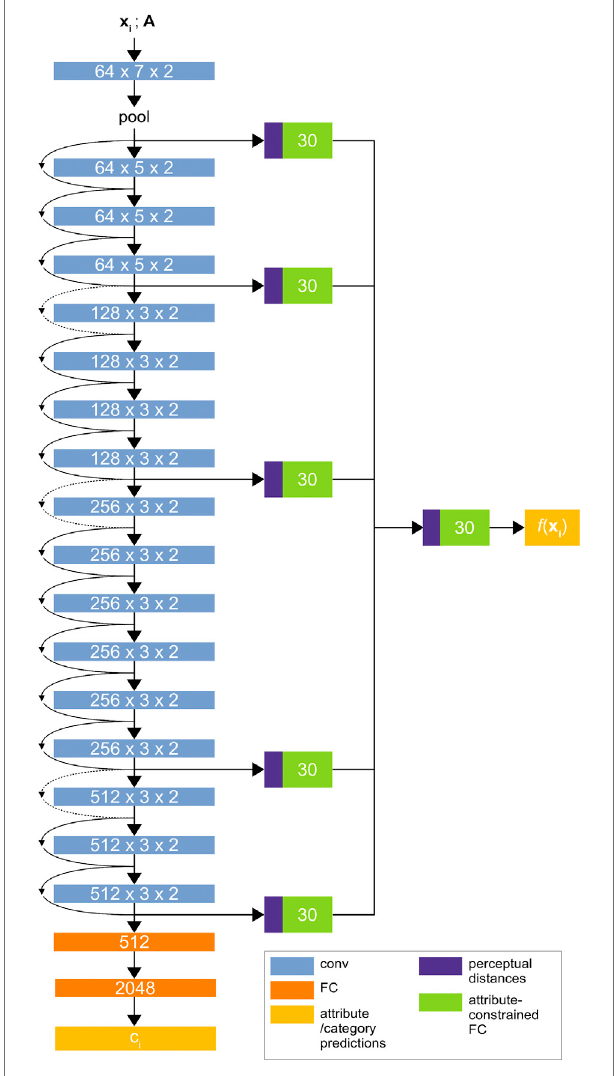
FIGURE 3 | The Material Attribute Classi fi er CNN (MAC-CNN) architecture. The network uses convolutional layers from ResNet34 (He et al., 2015)followed bysequential512-node and 2048-nodefully connected layers to predict the material category c i ∈ [ 0 , 1 ] K . An auxiliary network of fully connected layers also predicts the material attribute probabilities f ( x i )